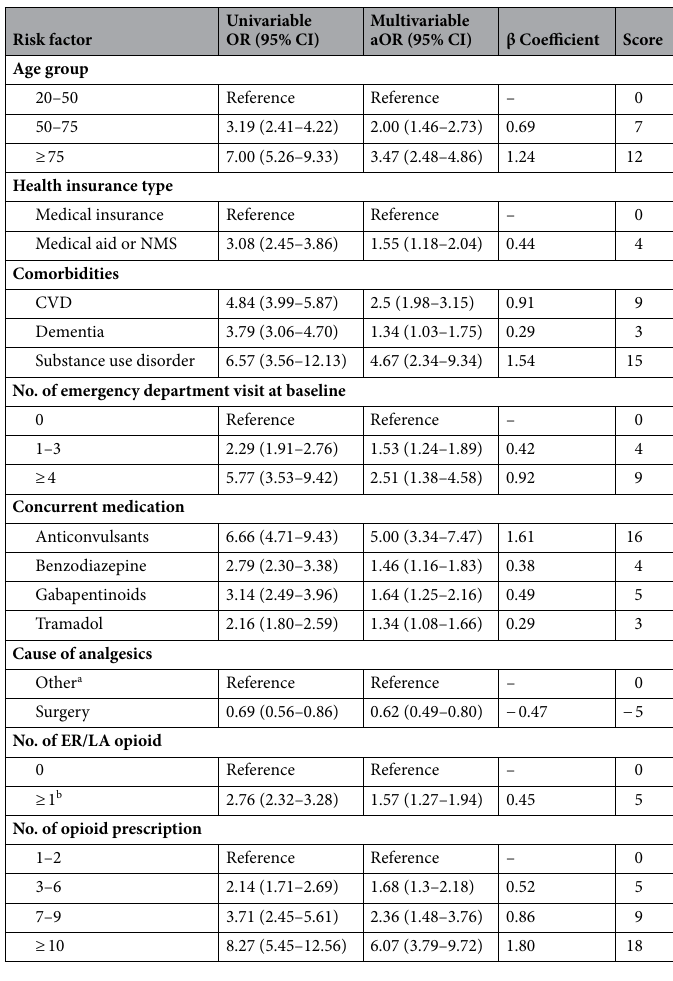
Table 3. Development of the predictive risk-score model for opioid overdose. CI confidence interval, NMS National Meritorious Service, CVD cerebrovascular disease, ER/LA extended-release and long-acting. a Traumatic injury was collapsed into other category. b For multivariable logistic regression model, ≥ 2 ER/LA opioid was collapsed into ≥ 1 ER/LA